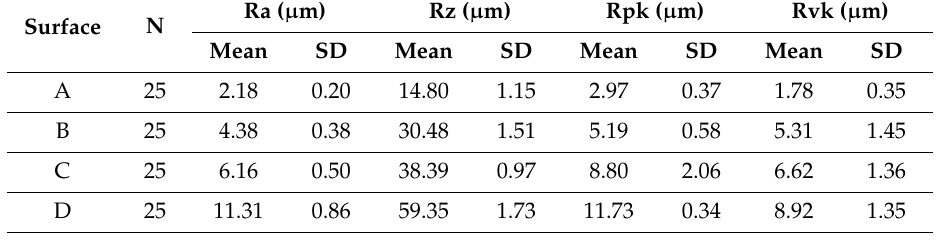
Table 2. The mean and standard deviations of the amplitude roughness parameters.